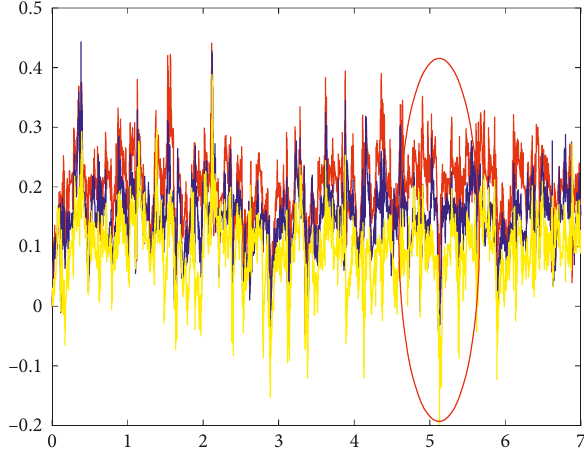
Figure 11: The weight vectors w